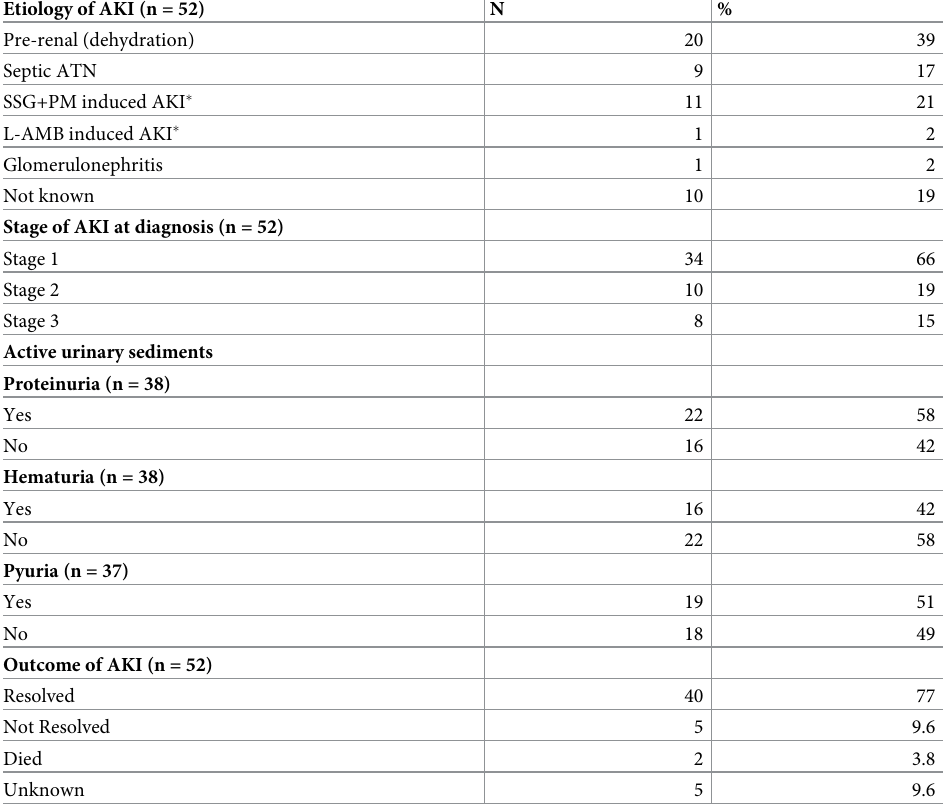
Table 3. Clinical characteristics of VL patients with AKI at LRTC between January 2019 –December 2019, Gon- dar, Ethiopia, N = 52. Etiology of AKI (n = 52) N